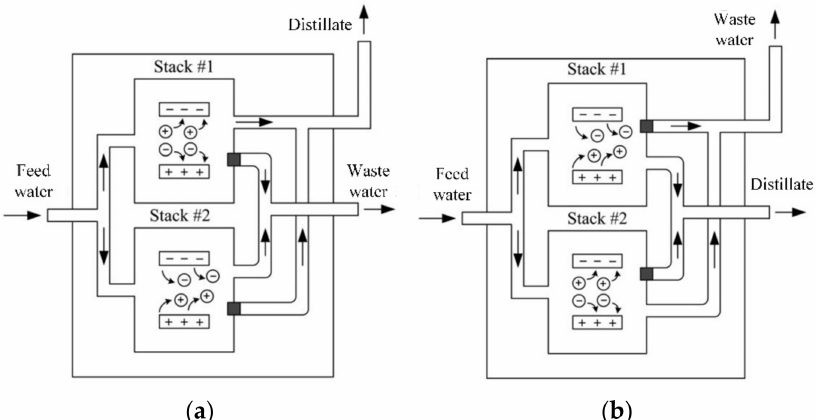
Figure 2. Working of two CDI stacks. ( a ) Stack #1 is in adsorption mode and Stack #2 is in regeneration mode. ( b ) Stack #1 is in regeneration mode and Stack #2 is in adsorption